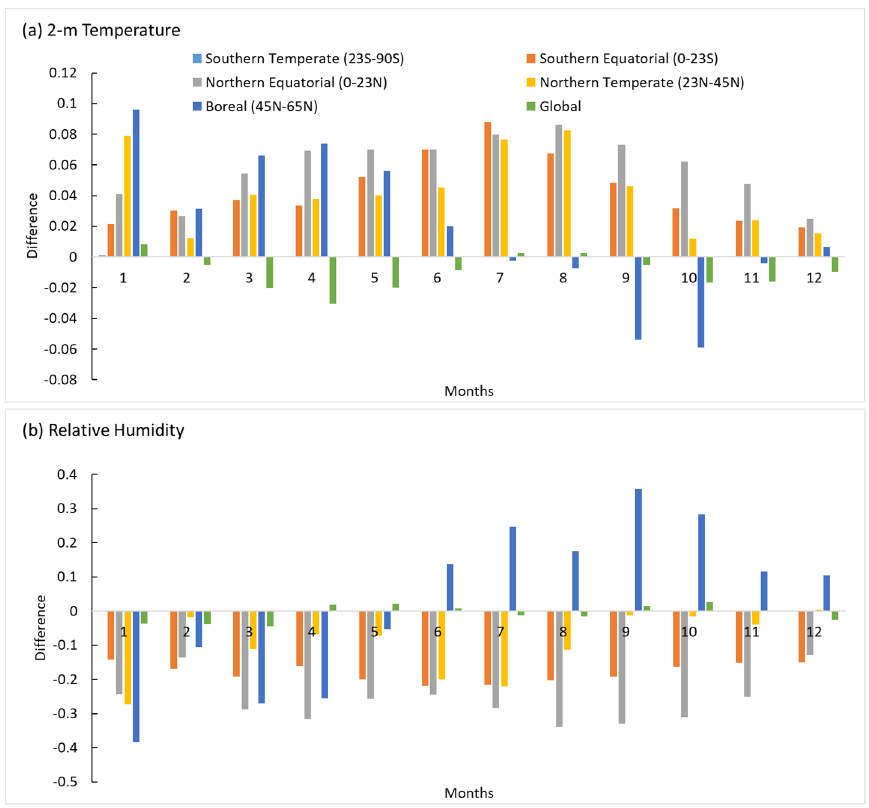
Figure 8. The zonal distribution of differences in ( a ) T2m (°C) and ( b ) RH (%) between ESACCI and CLM_LS.